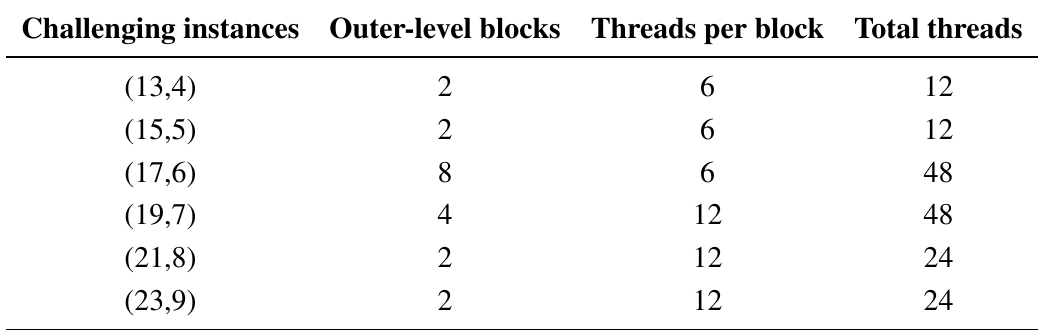
Table 1. Degree of inner and outer level parallelism for